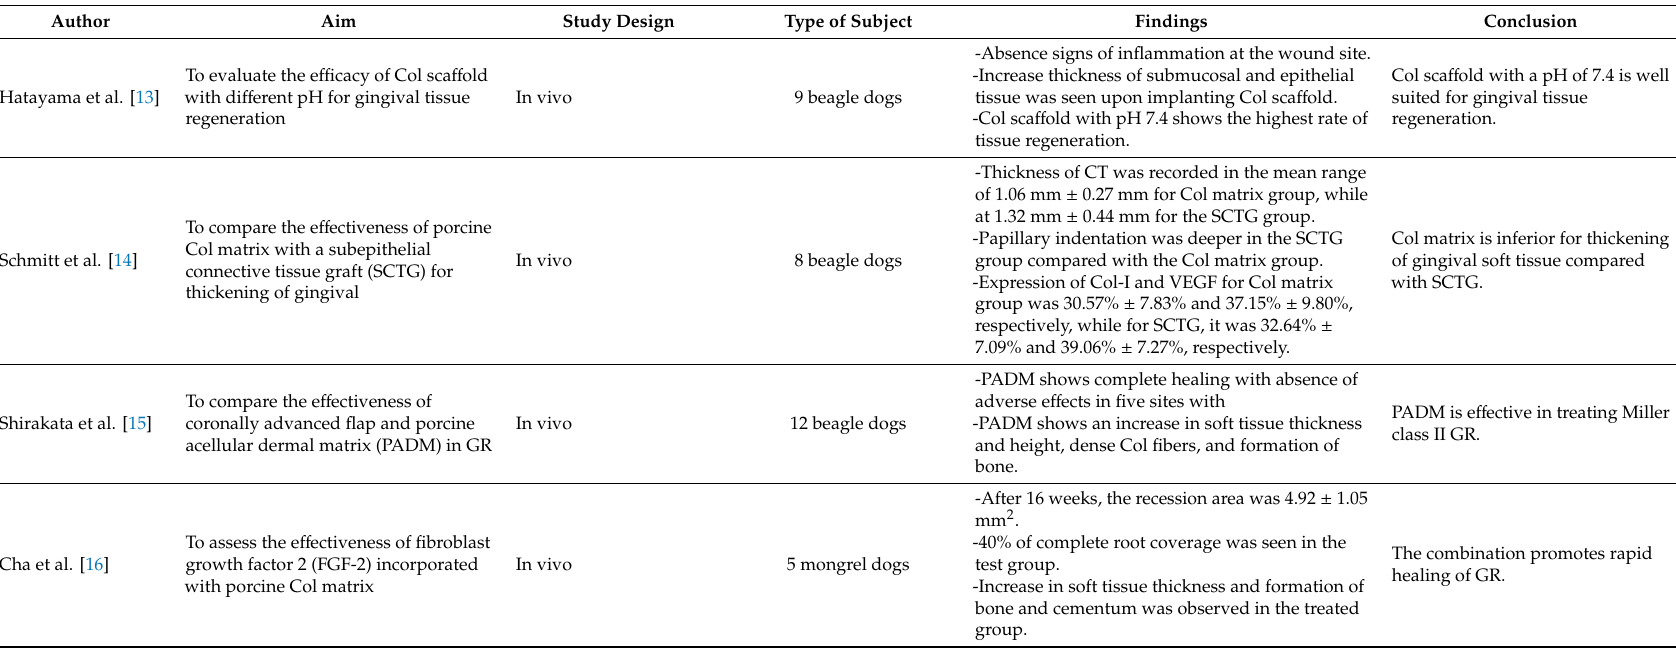
Table 2. The in vivo e ff ectiveness of gingival tissue regeneration. GR, gingival recession; CT, connective